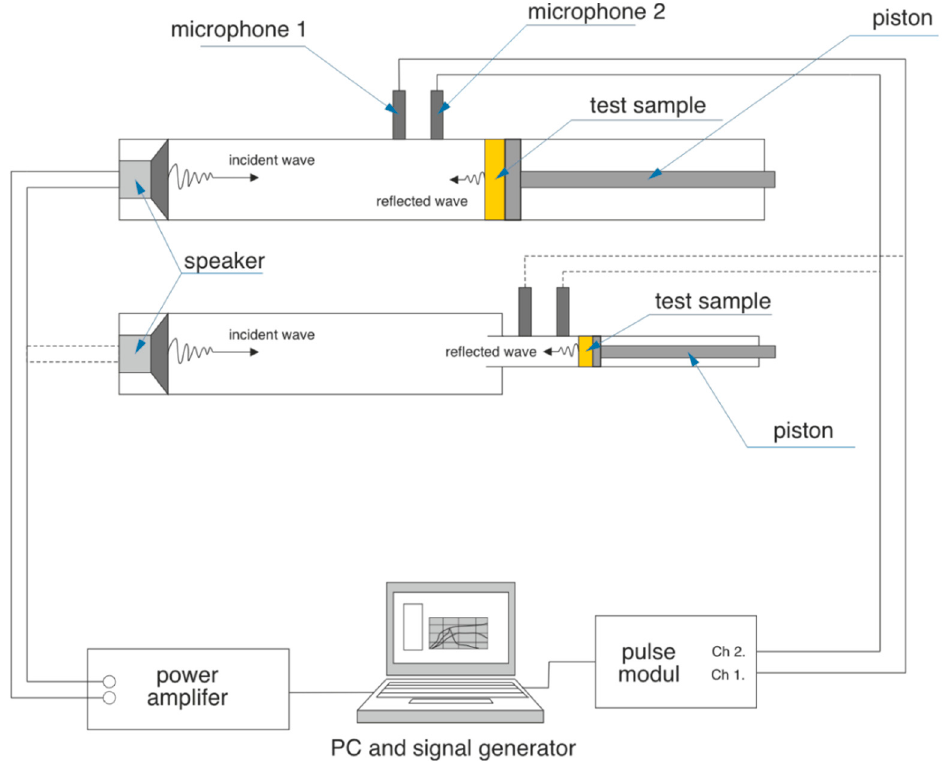
Figure 1. Scheme of the apparatus for measuring the sound absorption coefficient.